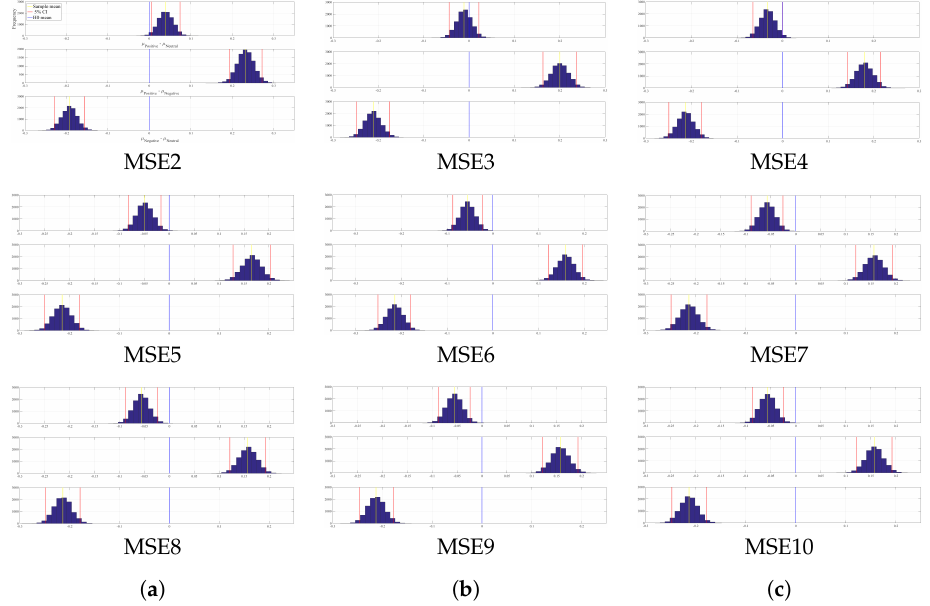
Figure A10. Paired two-sample bootstrap test of significance (10,000 simulation runs) at 95.0% confidence interval (CI) associated with the participants’ MSE2s (i.e., 62 MSE2s associated with 62 EEG channels of a participant, per affect) through MSE10s (i.e., 62 MSE10s associated with 62 EEG channels of a participant, per affect). In each subplot, the compared pairs of mental states are: Top: positive versus neutral, Middle: positive versus negative, and Bottom: negative versus neutral. X-axis: difference between average values of two affective states (e.g., positive versus negative). Blue line: non-significant difference between MSEs of two different affective states. Red lines: 95.0% confidence interval boundaries. Yellow line: average two affetective states’ mean differences over 10,000 simulations. The values associated with these figures are summarized in Table